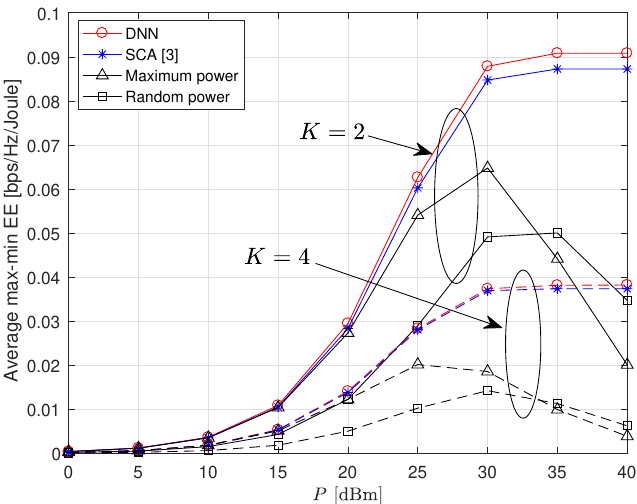
Figure 7. Average max-min EE performance as a function of P with P C = 33 dBm for K = 2 and 4.